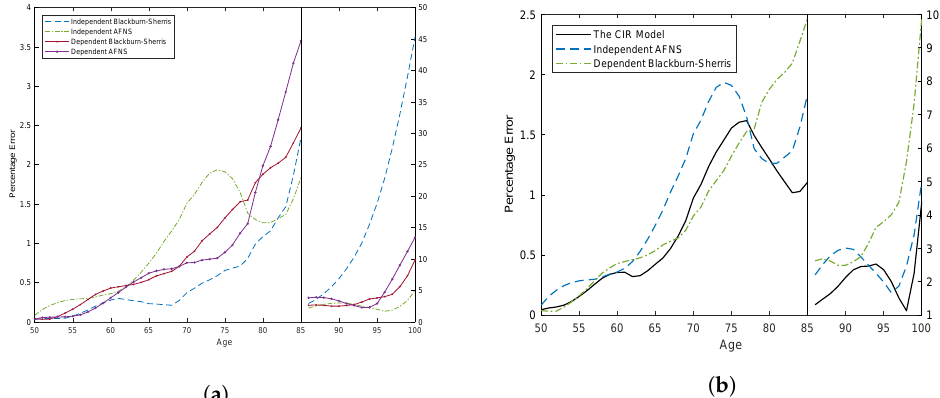
Figure 8. MAPE of Affine Mortality Models. ( a ) The Models with Gaussian Processes. ( b ) The CIR Model, the Dependent Blackburn–Sherris Model and the Independent AFNS